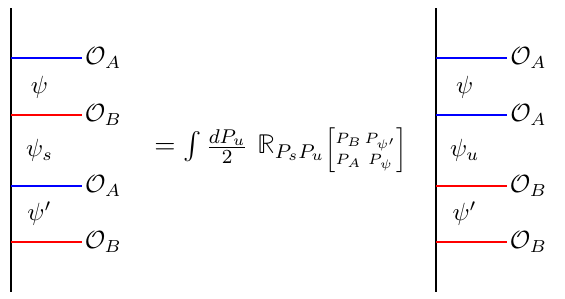
Figure 4 . Diagram of the braiding transformation that is need to compute out-of-time-ordered cor-